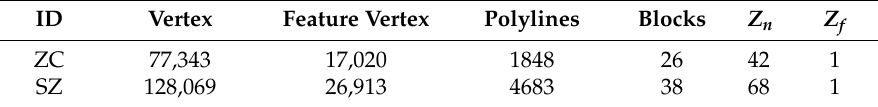
Table 1. Information of the original maps and the constructed watermarks.